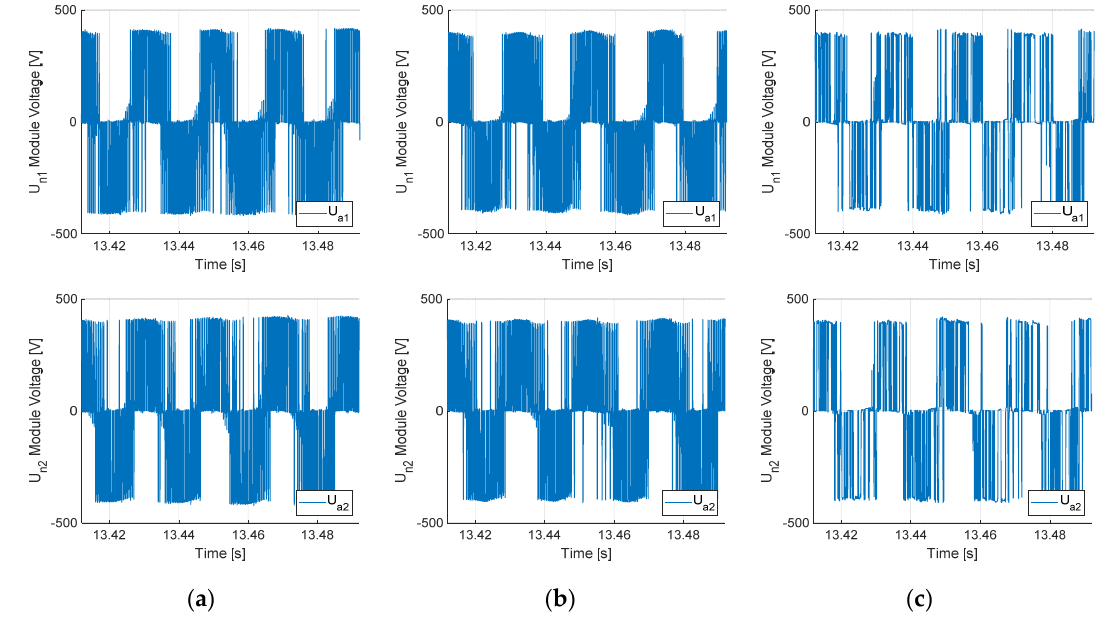
Figure 17. Synthesized STATCOM voltage per module: ( a ) CHB (4000 µ F ) ; ( b ) CHB ( 1200 µ F ) ; ( c ) CHB-SDC ( 1200 µ F )